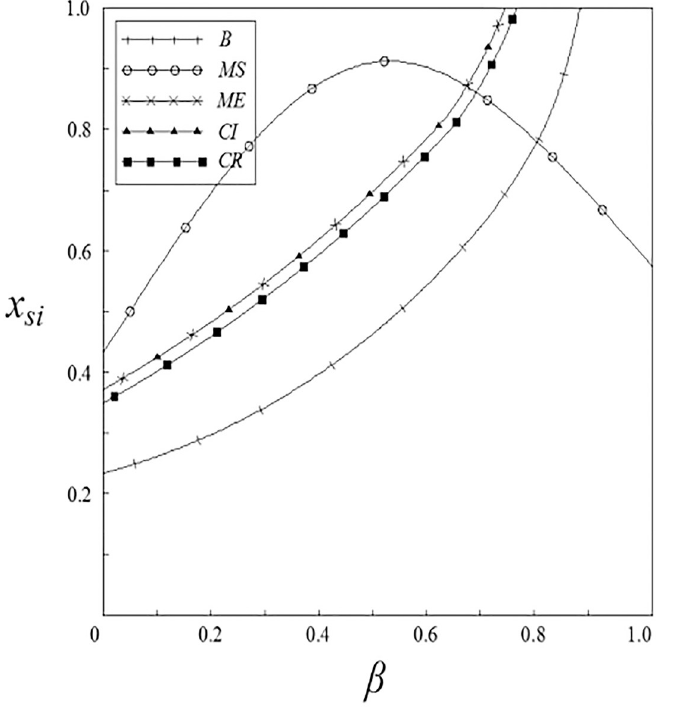
Fig 2. The relationship between x si and β